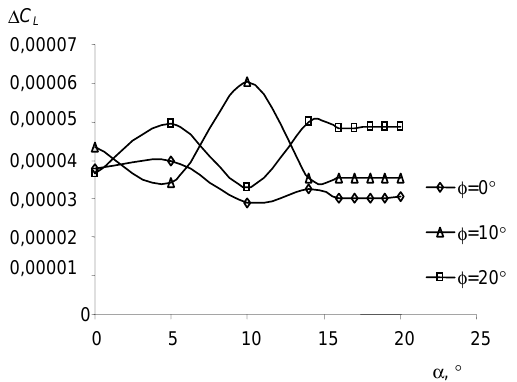
Fig 1 . Calculation error of wing lift force coefficient dependence on wing sweep. NACA4415 wing Re=2,1 × 10 6 , AR=6,2